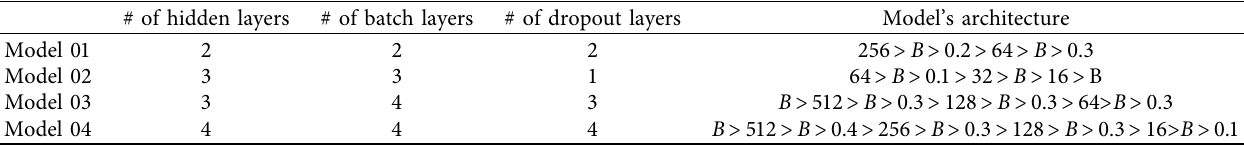
Table 4: Different model’s architectures for DNN technique.